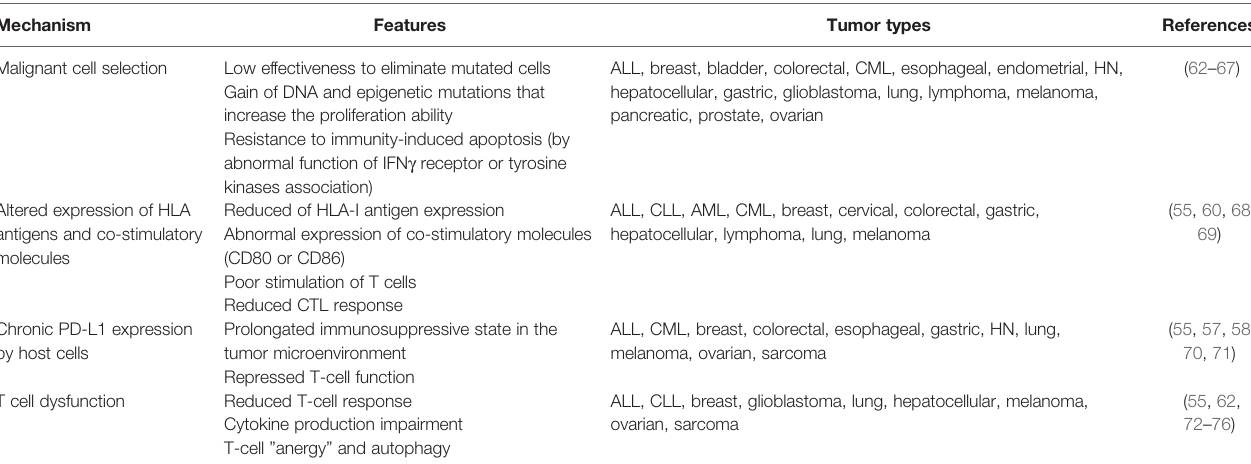
TABLE 1 | Potential mechanisms of tumor immune